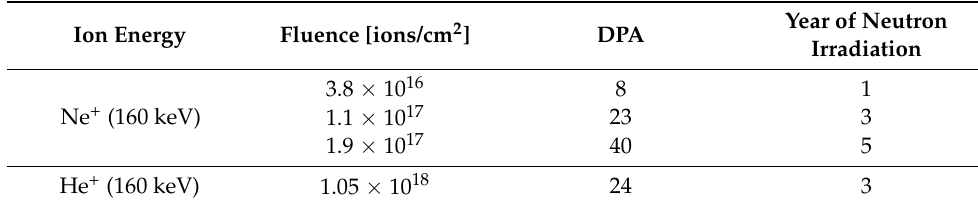
Table 1. Parameters used for the irradiation experiment.